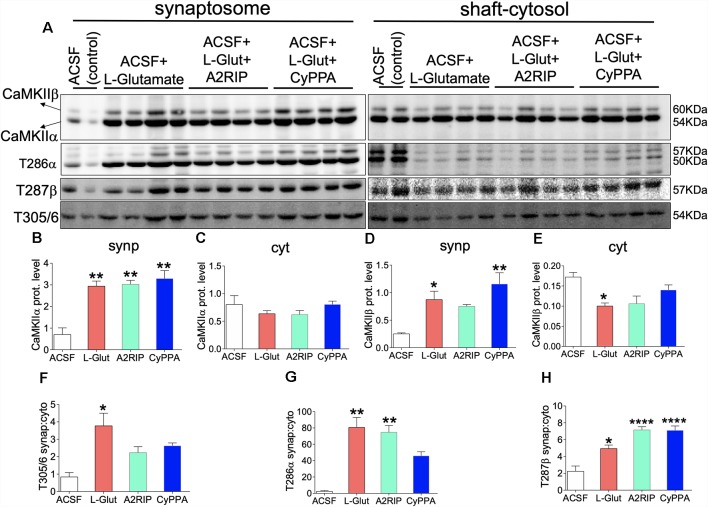
SK channel potentiation impacts hippocampal synaptic translocation of T286/T287 pCaMKIIα/β. (A) Representative western blots illustrating synaptosomal and shaft-cytosol level of CaMKIIα, CaMKIIβ, T286 pCaMKIIα, T287 pCaMKIIβ, and T305/306 pCaMKII. Bar graphs illustrating; (B) synaptosomal expression of CaMKIIα. (C) Shaft-cytosol expressions of CaMKIIα. (D) Synaptosomal expression of CaMKIIβ. (E) Shaft-cytosol expressions of CaMKIIβ. (F) Level of normalized synaptic T305/306 pCaMKII relative to shaft-cytosol expression. (G) Level of normalized synaptic T286 pCaMKIIα relative to shaft-cytosol expression. (H) Level of normalized synaptic T287 pCaMKIIβ relative to shaft-cytosol expression (B–H; *p < 0.05, **p < 0.01, ****p < 0.0001).